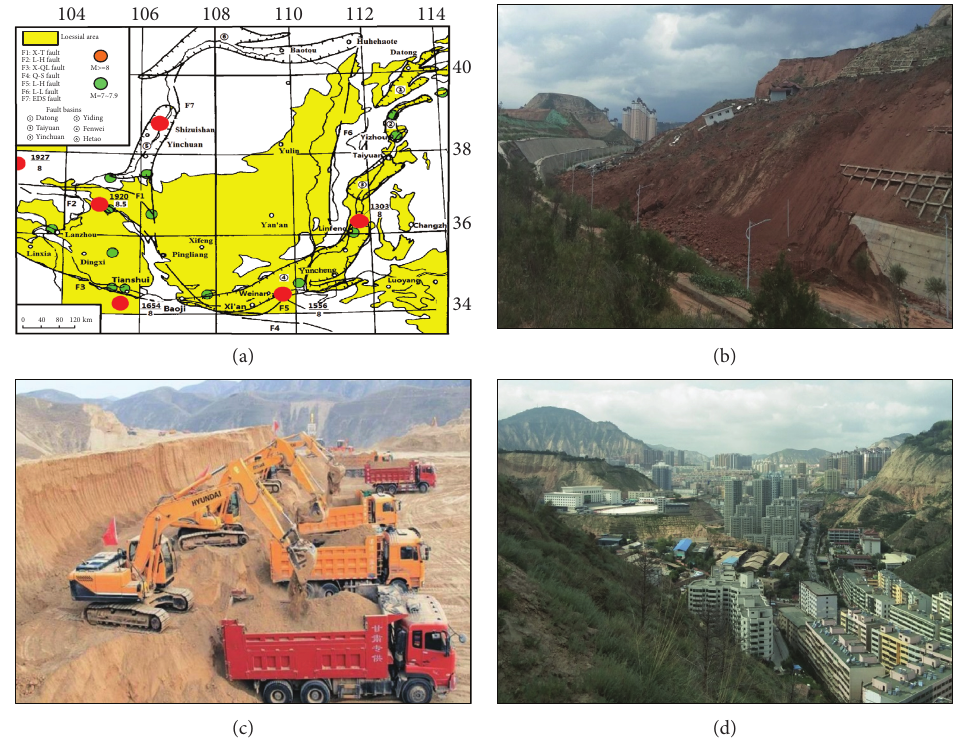
Figure 1: Engineering activities and earthquake landslide risk in the Loess Plateau. (a) Distribution of historical earthquakes. (b) Sliding of an engineering slope. (c) Cutting slope to making land. (d) Buildings adjacent to